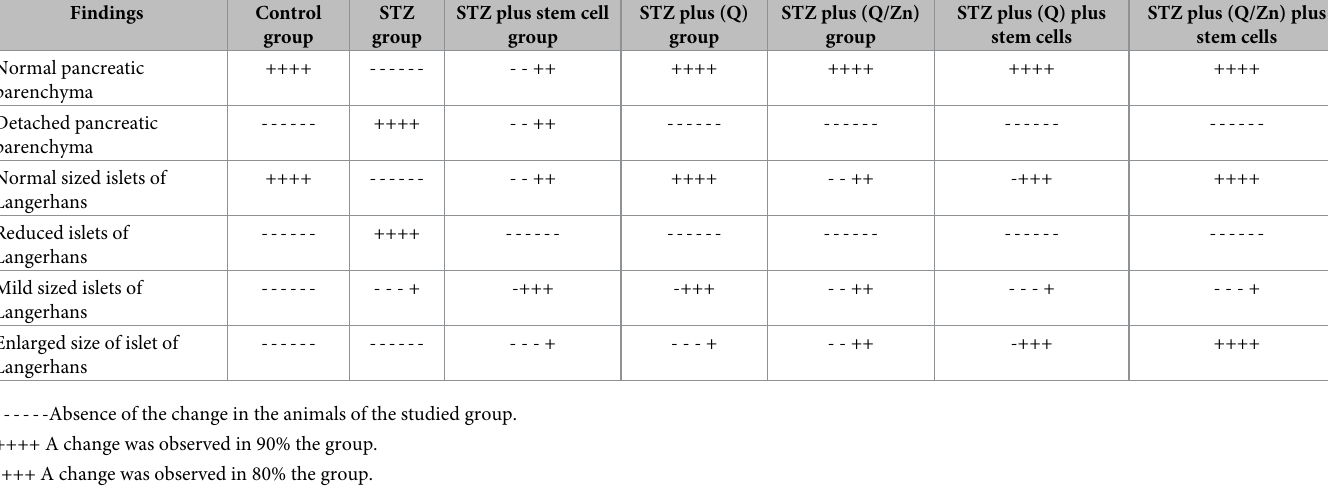
Table 7. Histopathological findings in pancreatic tissues of normal rats, diabetic non treated rats and diabetic treated rats with either quercetin, quercetin/Zn, or stem cells separately or in combination.